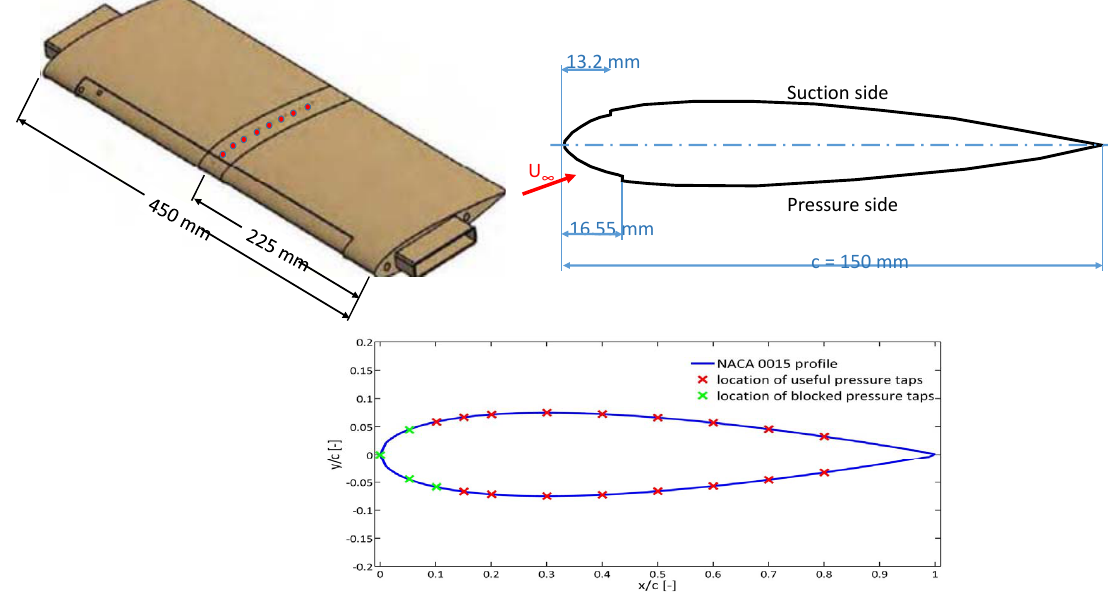
Figure 1. ( top ) A 3D view of the model used with a NACA 0015 profile ( top left ) with the insert indents for fixing to the Wind Tunnel section side walls, and a cross-section of the model showing the recess in the profile. ( bottom ) The profile “blown-up” in the y-direction for clarity to see the marked pressure tap locations used. The green ones were blocked by the